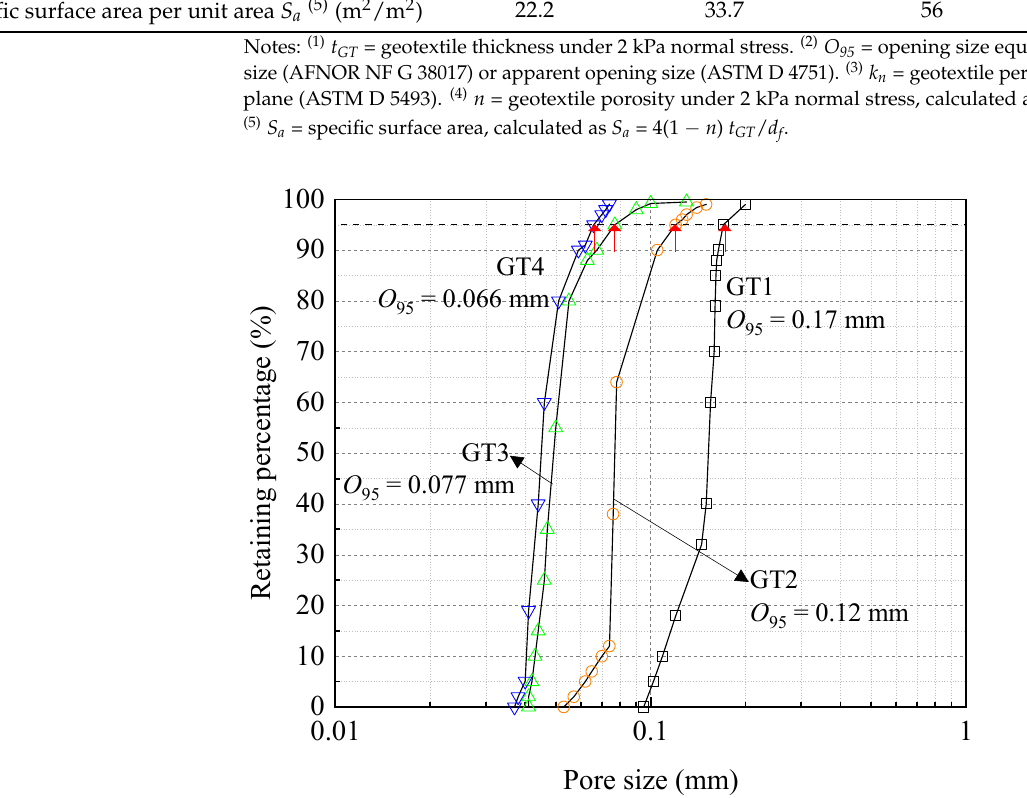
Figure 1. Pore size distribution of the test geotextiles.